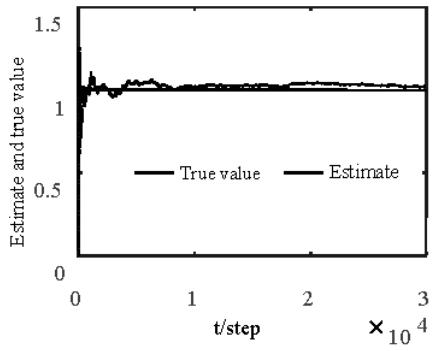
Figure 9. Identification of noise variance w Q .